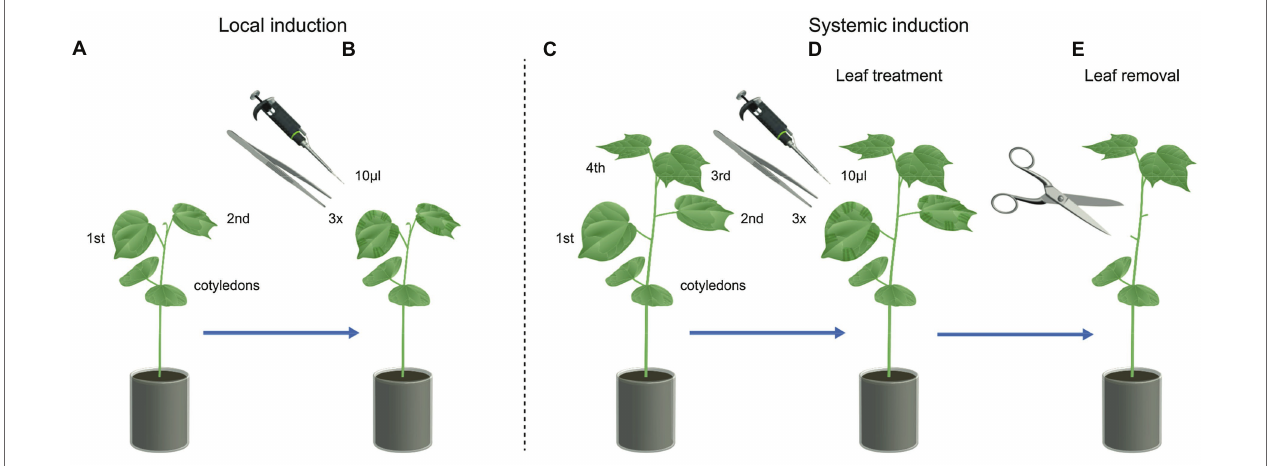
FIGURE 1 | Illustration of simulated herbivory on cotton plants. Local induction: (A) Two-leaves stage cotton plants used to measure local herbivore-induced plant volatile (HIPV) emissions. (B) The first and second leaf were wounded three times with a serrated forceps and immediately afterward 10 μ l of regurgitant were applied on the wounded sites, the HIPVs were collected over time. Systemic induction: (C) Four-leaves stage cotton plants used to measure systemic HIPV emissions. (D) The first and second leaf were wounded three times with a serrated forceps and immediately afterward 10 μ l of regurgitant were applied on the wounded sites. (E) To measure systemically induced volatiles emissions (from the third and fourth leaf), the treated first and second leaves were removed right before the volatile